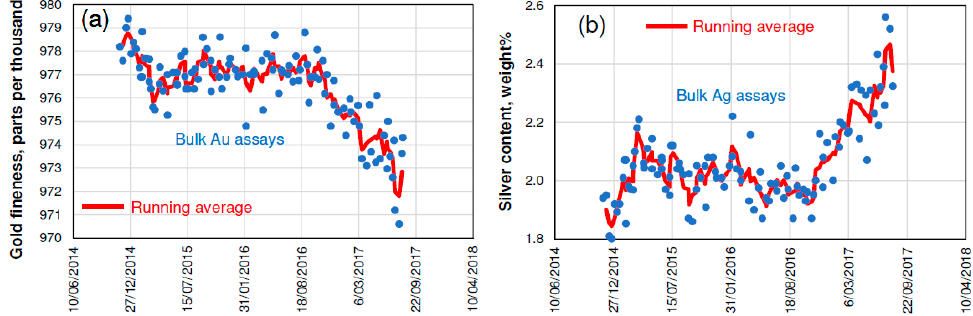
Figure 3. Compositions of dor é bars from bulk gold production at Waikaia mine over time. ( a ) Variation in Au fineness over time; ( b ) Silver content of dor é bars. Blue dots are actual data; red lines are running averages of three bar